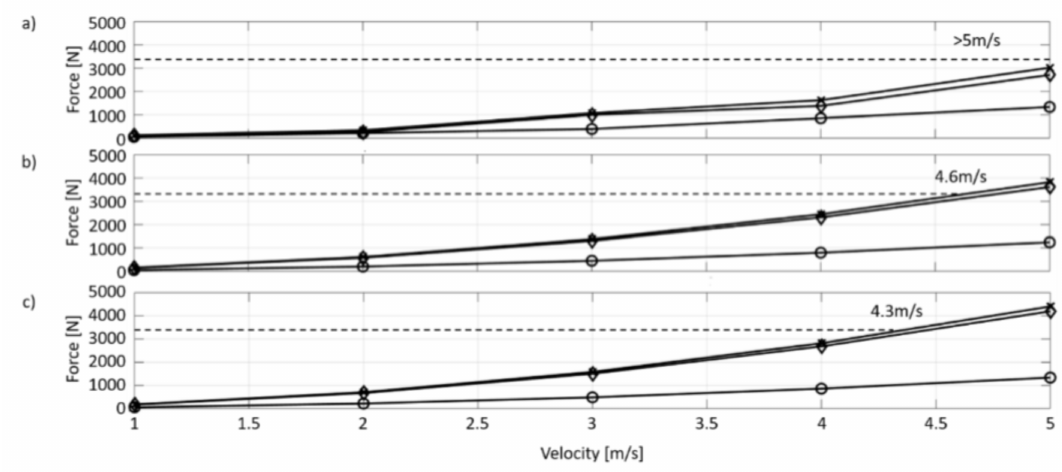
Figure 13. Resulting force. ( a ) Angle of attack: 0 ◦ . ( b ) Angle of attack: 5 ◦ . ( c ) Angle of attack: 10 ◦ . Round marker: drag force. Diamond marker: lift force. Cross marker: total resulting